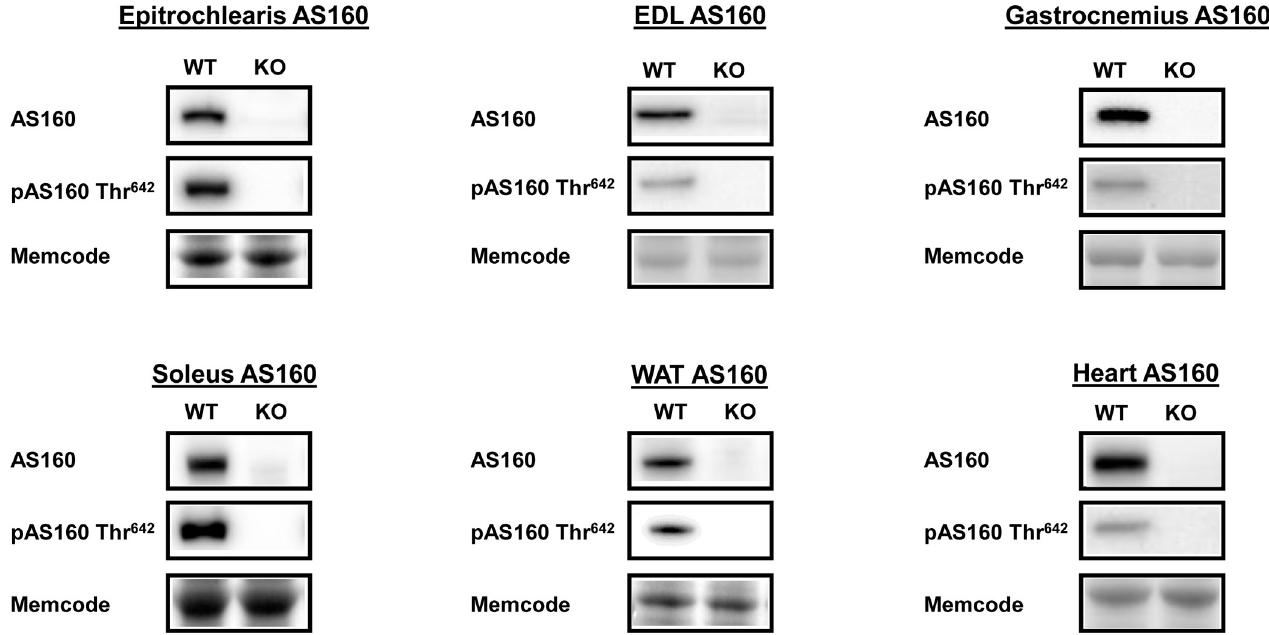
Fig 1. Tissue AS160 abundance and phosphorylation (pAS160 Thr 642 ) from WT and KO rats subjected to the HEC. Extensor digitorum longus = EDL. White adipose tissue = WAT. Representative immunoblots and Memcode protein stain loading controls are included. AS160 abundance and pAS160 Thr 642 were undetectable in all of the tissues from KO animals. N = 6 animals in each group.